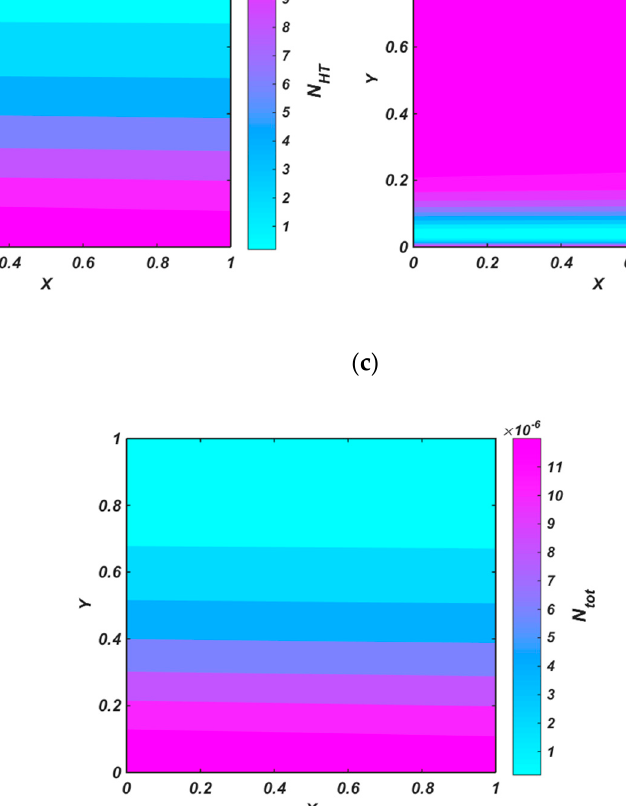
Figure 10. N(cid:3368) (cid:3047)(cid:3042)(cid:3047) as a function of Re in different values of porosity ε . Figure 11a illustrates the variations in the Bejan (Be) number as a function of the Reynolds number in the various pore densities. Since the heat transfer irreversibility contributes greatly to the total irreversibility, the Bejan number is very close to 1. An increase in the pore density enhances the heat transfer by increasing the velocity gradient in areas close to the hot wall and decreasing the heat transfer irreversibility. Therefore, by increasing the pore density, the Bejan number decreases. The effect of the Reynolds number on the Bejan number depends on the pore density. In other words, the higher the pore density, the greater the reduction in the Bejan number due to the increase in the Reynolds number.